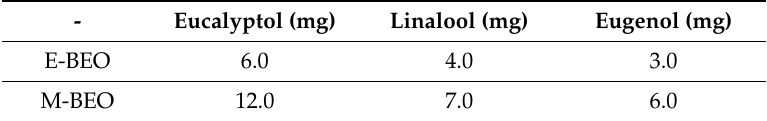
Table 1. Eucalyptol, linalool and eugenol amount in bay leaves essential oil extracted with ethanol (E-BEO) and methanol (M-BEO) by gas chromatography (GC) analysis.